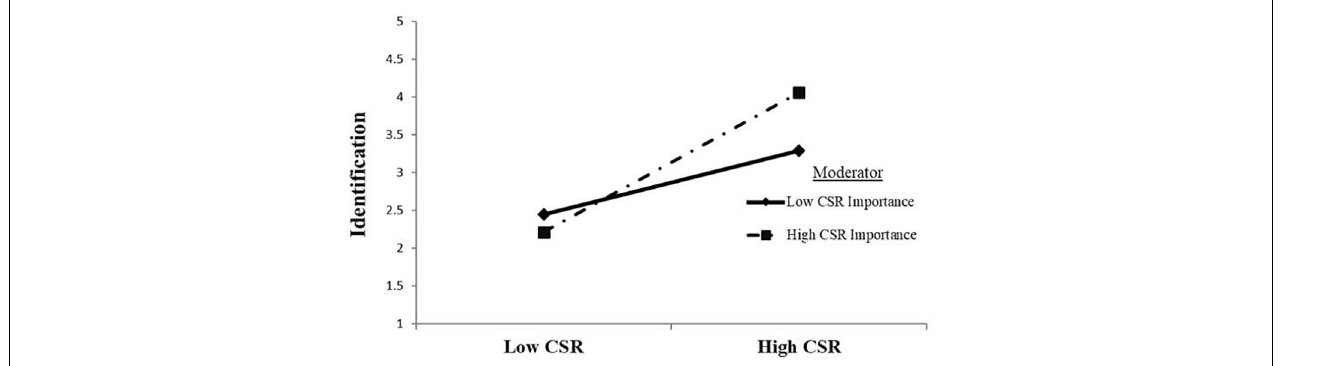
FIGURE 3 | The moderation of corporate social responsibility (CSR) importance on CSR and